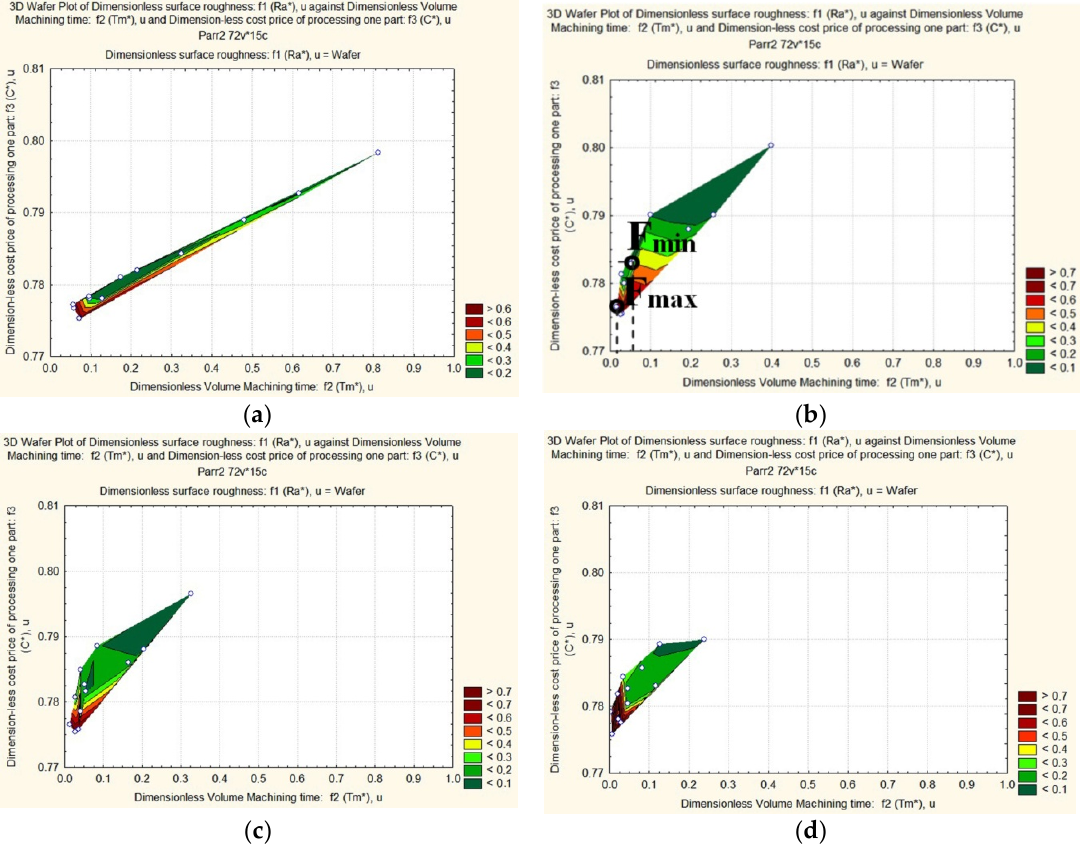
Figure 10. Surface projections of Ra * values depending on the change in the values of С * and T m * at a fixed depth of cut (ECAP-4 hardening of an AA6061 alloy workpiece): ( a ) a p = 0.1 mm; ( b ) a p = 0.25 mm; ( c ) a p = 0.3 mm; ( d ) a p = 0.4 mm.